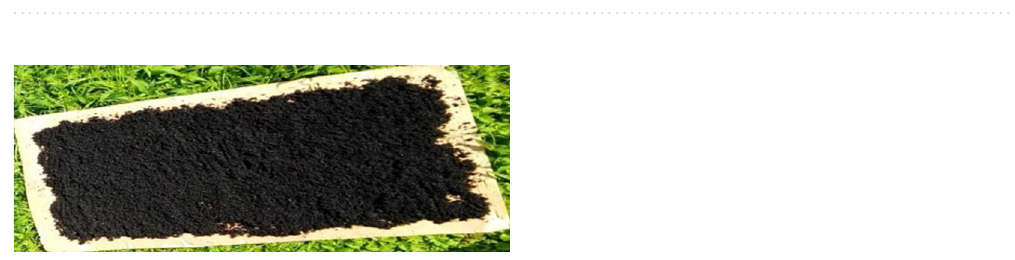
Figure 1. Rice-husk feedstock.